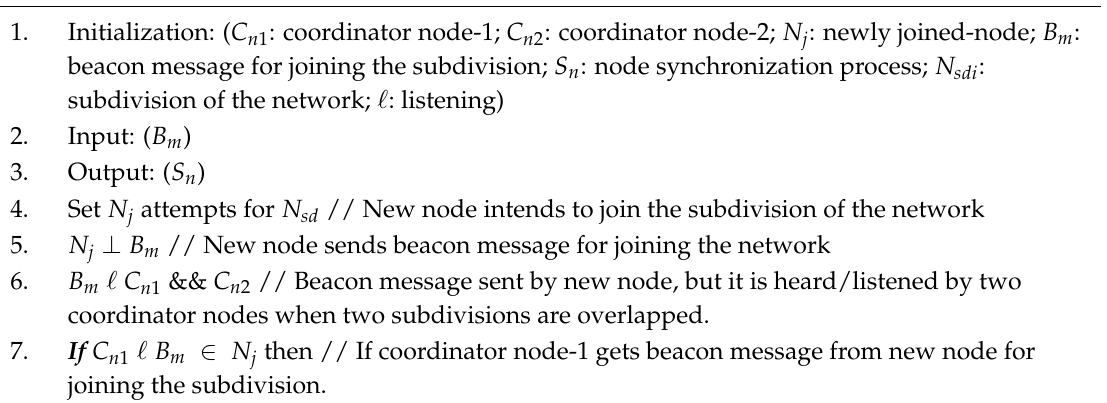
Algorithm 1 : Priority-based synchronization process between coordinator and newly joined nodes